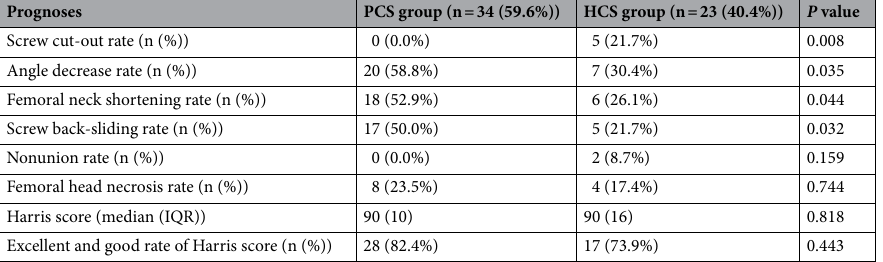
Table 5. Prognoses of patients with different internal fixation groups. IQR stands for interquartile range.